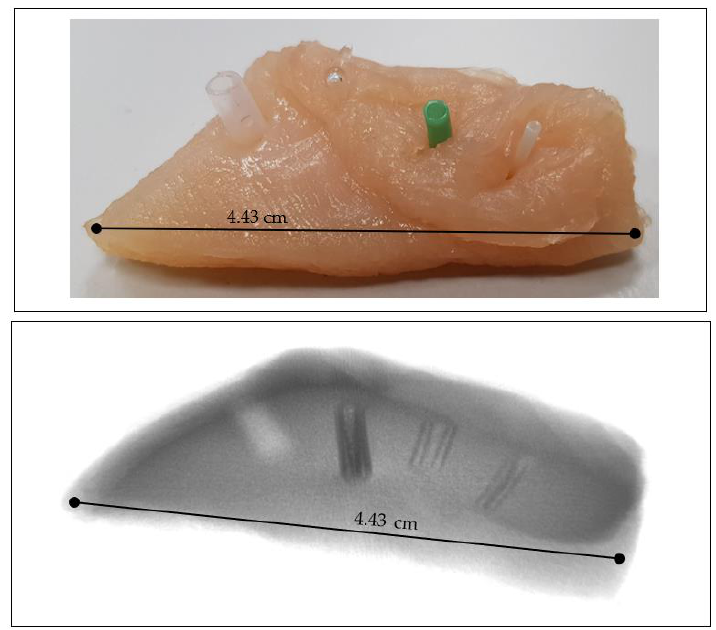
Figure 1. Chicken sample with capillaries as vascular phantom ( top ) and phantom X-ray image ( bottom ); materials from left: bioplastic PLA, glass, green silicone, and transparent silicone. Scale is in [cm].